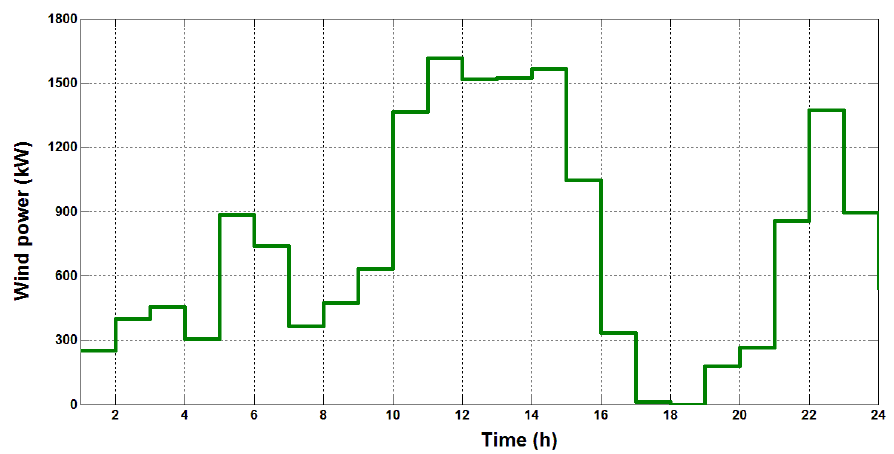
Figure 4. Wind generation prediction.